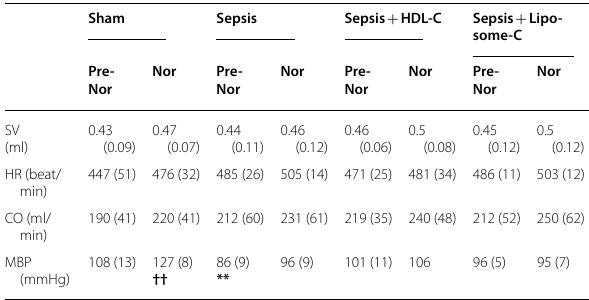
Table 2 Response to